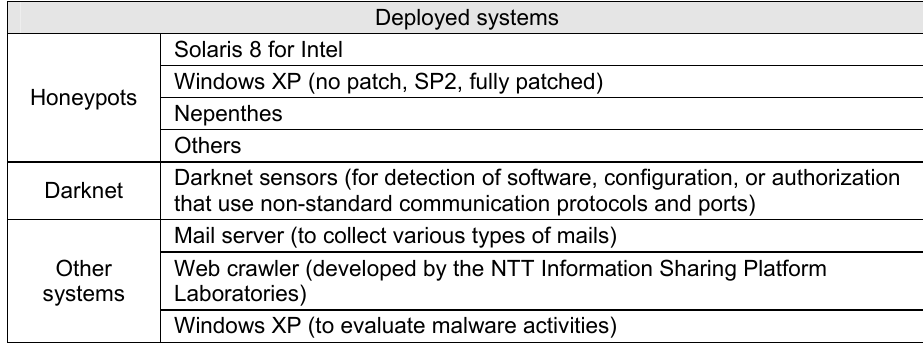
Table 5 – Deployed honeypots, darknet and other